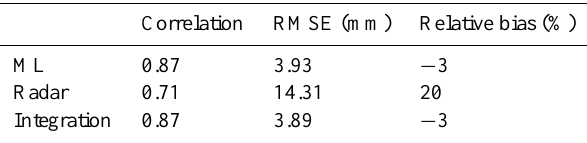
Table 1. Performance analysis event (1) – Ramle site.